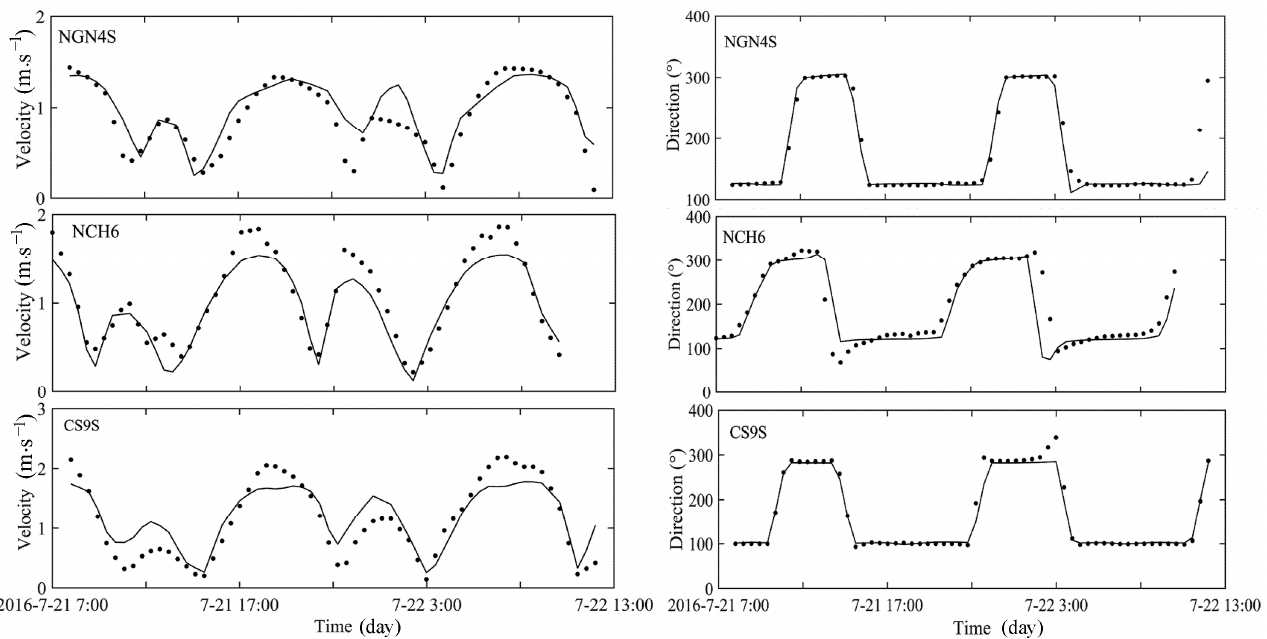
Figure 7. Verification of depth-averaged tidal velocity and direction (dots denote the observed data; line denotes the simulation data).